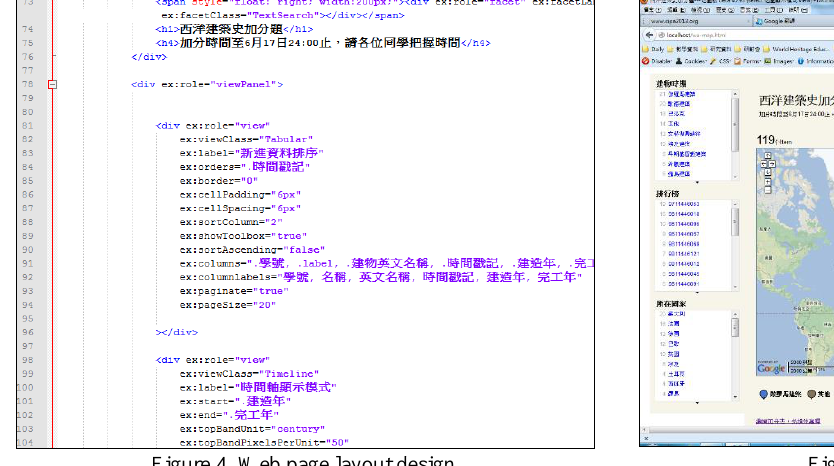
Figure 7. Map mode View